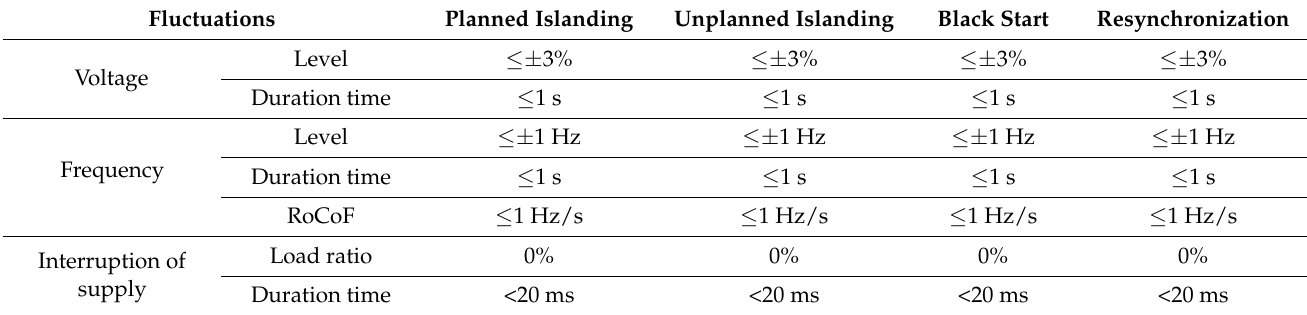
Table 3. Microgrid assessment matrix for transition between grid-connected and island operation mode (example values for sensitive